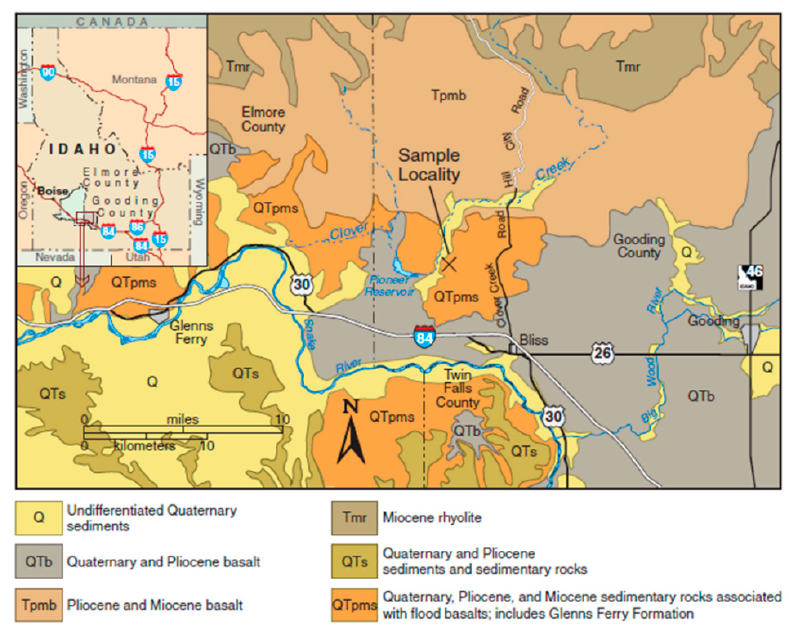
Figure 3. Locality map of the fossil site in Idaho, modified from Lewis et al. [19] (courtesy of William W. Besse).